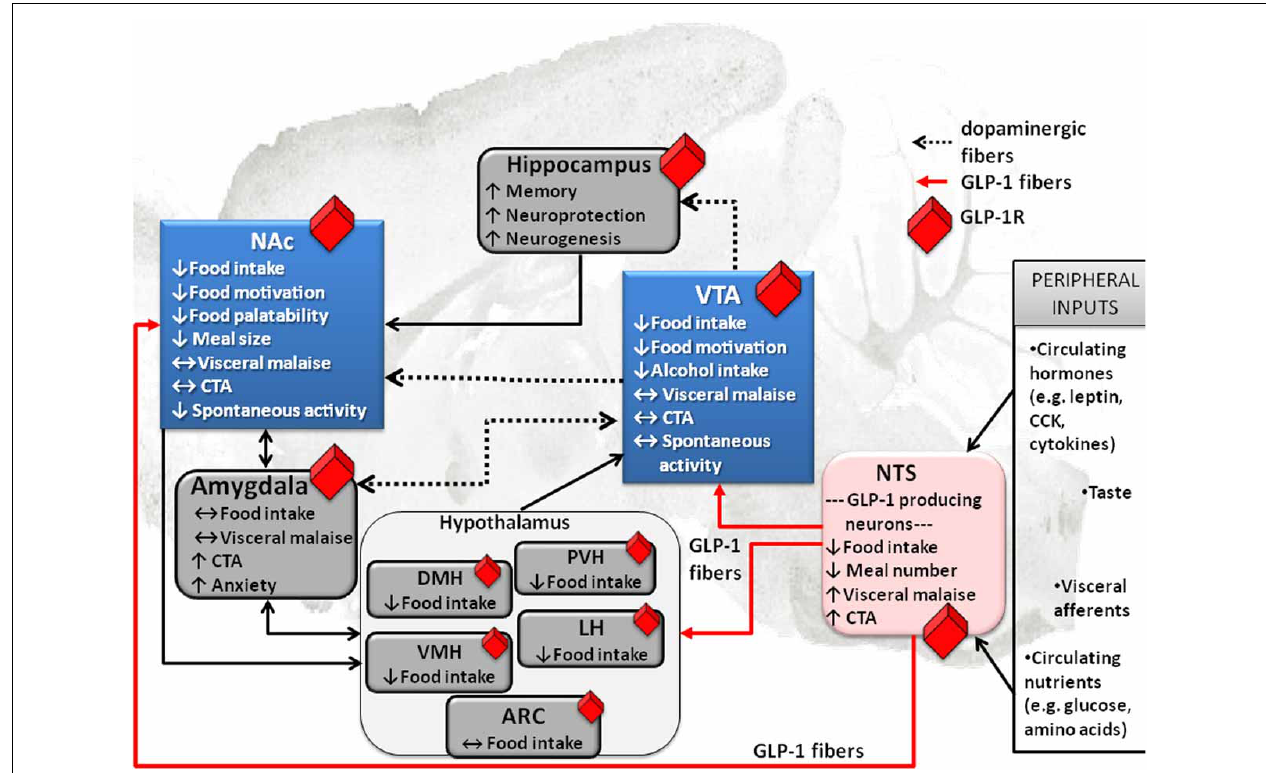
FIGURE 1 | Effect of GLP-1 on food intake and associated behaviors is neuroanatomicaly distributed. Local application of GLP-1 or GLP-1 analogs (e.g., EX4) into the VTA or the NAc alters food motivation/reward. Moreover, many other GLP-1R expressing CNS sites that directly respond to GLP-1 have clear connections to the mesolimbic dopamine circuitry, key in food reward behaviors (indicated in blue). This neuroanatomical distribution of GLP-1R potentially allows for a multi-center, wide-spread impact of GLP-1on food reward behavior, at several levels of the CNS. Furthermore, it appears that GLP-1 influences feeding in different brain regions by partly overlapping and partly distinct mechanisms. Several GLP-1 terminal sites have been confirmed (in red). Notably two of them are mesolimbic; VTA and